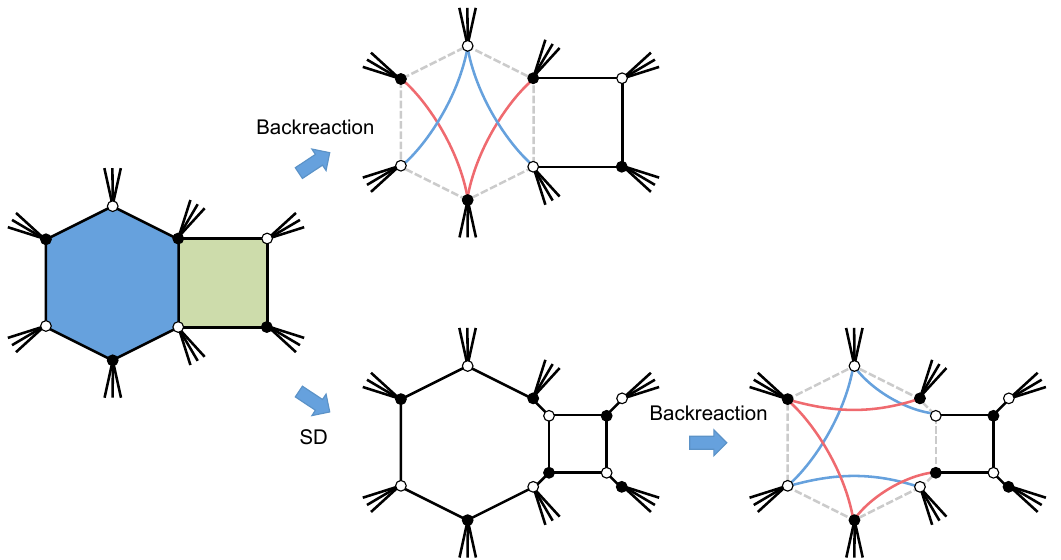
Figure 35. Seiberg duality on a face (green) adjacent to a D-brane instanton (blue). On the (cid:12)rst row we show the instanton backreaction on the original theory. On the second row, we (cid:12)rst apply Seiberg duality and then backreact the face originally occupied by the instanton.